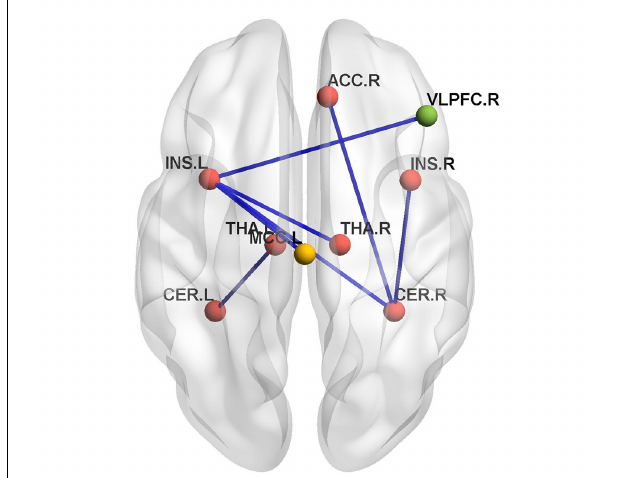
FIGURE 2 | Brain regions showing significantly decreased iFC strength within the SN, and between the SN subregions and the DMN, and the ECN in patients with OCD. INS.L, left insula; INS.R, right insula; THA.L, left thalamus; THA.R, right thalamus; CER.L,left cerebellum; CER.R, right cerebellum. ACC.R, right anterior cingulate cortex; MCC.L, left middle cingulate cortex; VLPFC.R, right ventral lateral prefrontal cortex. The red, yellow, and green balls represent the SN, DMN, and ECN, respectively. The blue lines indicate decreased iFC strength in patients with OCD.